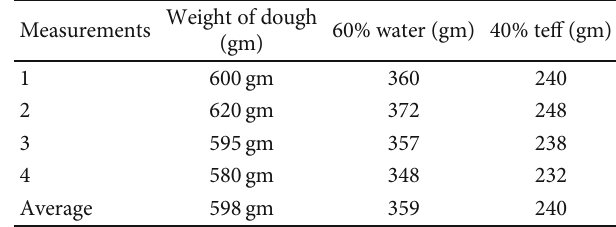
Table 6: Various weight of dough measured at di ff erent